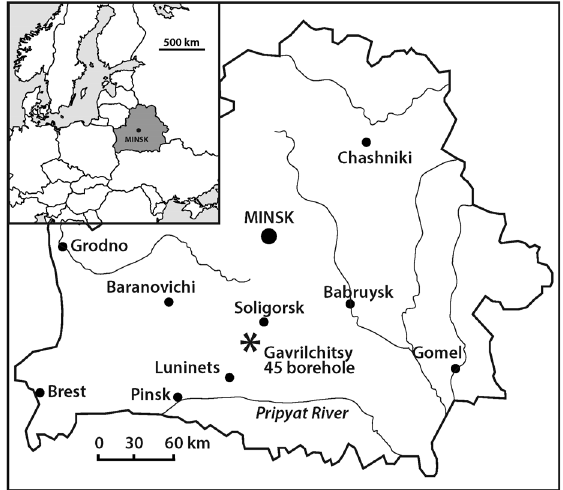
Fig. 1. Locality map, modified from Plax (2008a, fig.